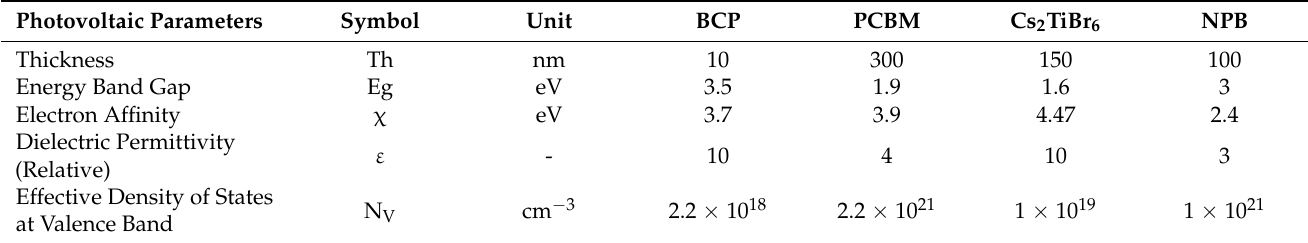
Table 1. Materials parameters of BCP, PCBM, Cs 2 TiBr 6 , and NPB incorporated for these simulations are listed, where each layer thickness is just reported for the first estimation, which will further improve in later stages of the simulation. Photovoltaic